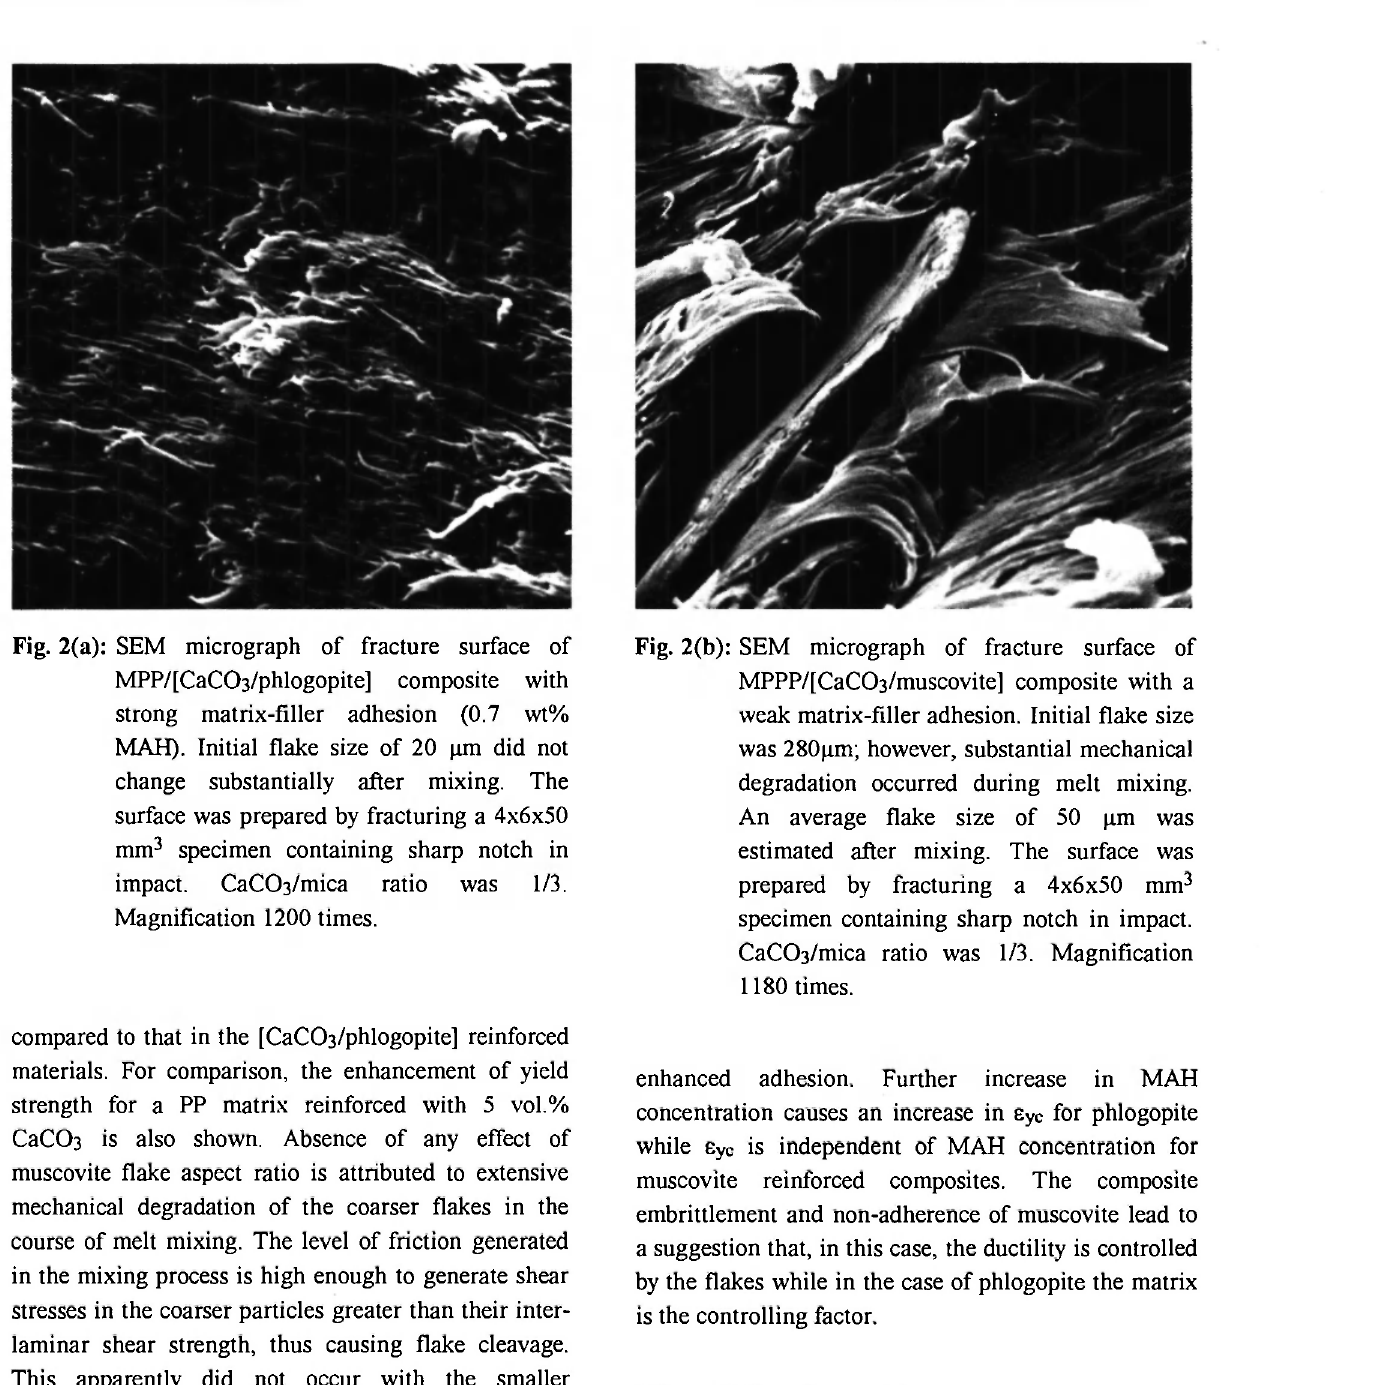
Fig. 2(b): SEM micrograph of fracture surface of MPPP/[CaC03/muscovite] composite with a weak matrix-filler adhesion. Initial flake size was 280μηι; however, substantial mechanical degradation occurred during melt